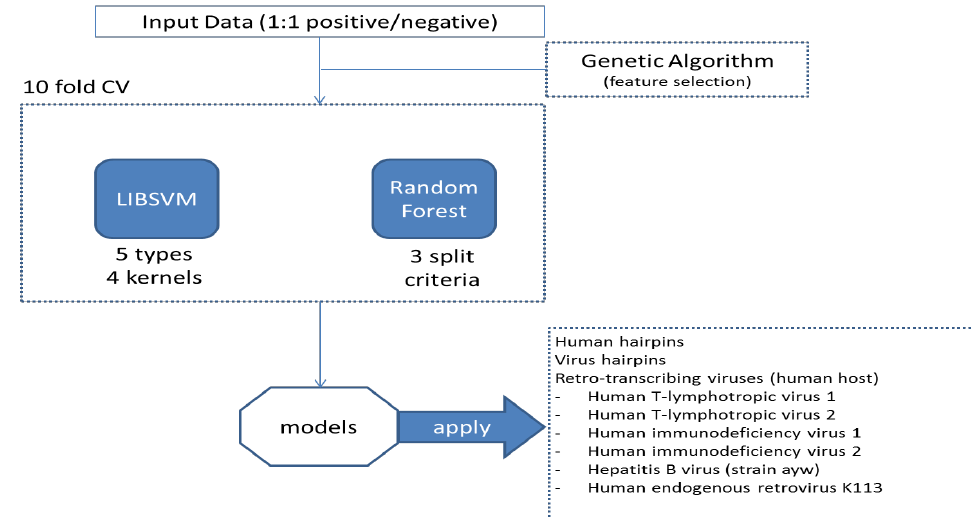
Figure 1: Workflow for the classification system used in this